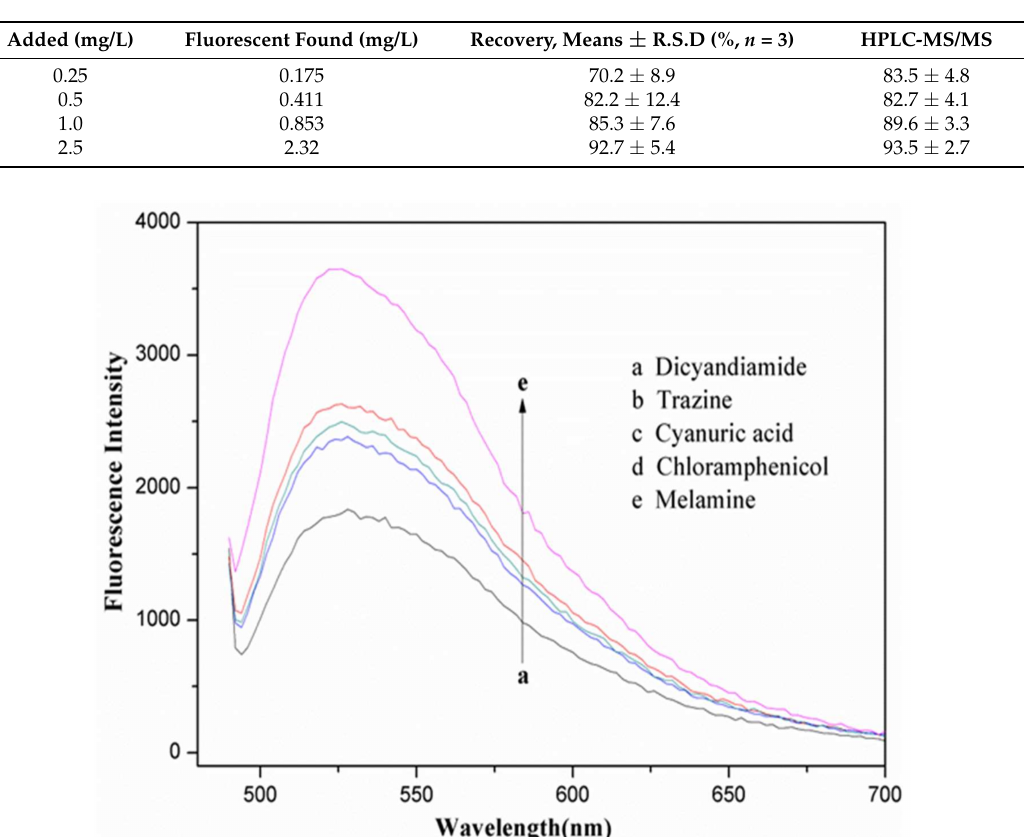
Figure 6. Fluorescence spectra of FITC-Mel with different interfering substances by conducting experiments at the same concentration (1.0